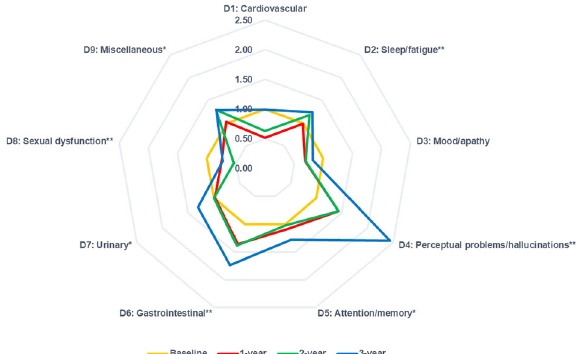
Fig. 2 Comparison of NMSS domain scores at baseline, 1-, 2-, and 3-year. Illustrates: NMSS domain scores at baseline (golden), 1-year follow-up (red), 2-year follow-up (green), and 3-year follow-up (blue). In the radar chart, all values were normalized to baseline values (mean follow-up score/mean baseline score), and baseline values for all the NMSS domains were set to 1.0. Signi fi cantly increased scores were observed in D2, D4, D5, D6, D7, and D9 domains, while signi fi cantly decreased scores were observed in the D8 domain. Bigger areas compared to baseline represented more severe NMS at follow-up visits. Abbreviations: NMSS, Non-Motor Symptoms Scale; NMS, non-motor symptoms. * P < 0.05 and ** P < 0.01 based on Friedman test.